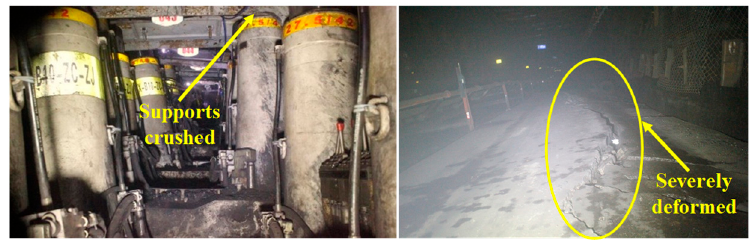
Figure 7. Roadway deformation.